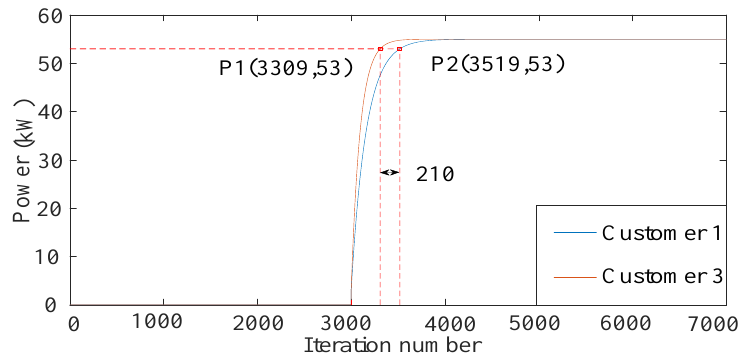
Figure 8. The IC when choosing different dominant nodes.